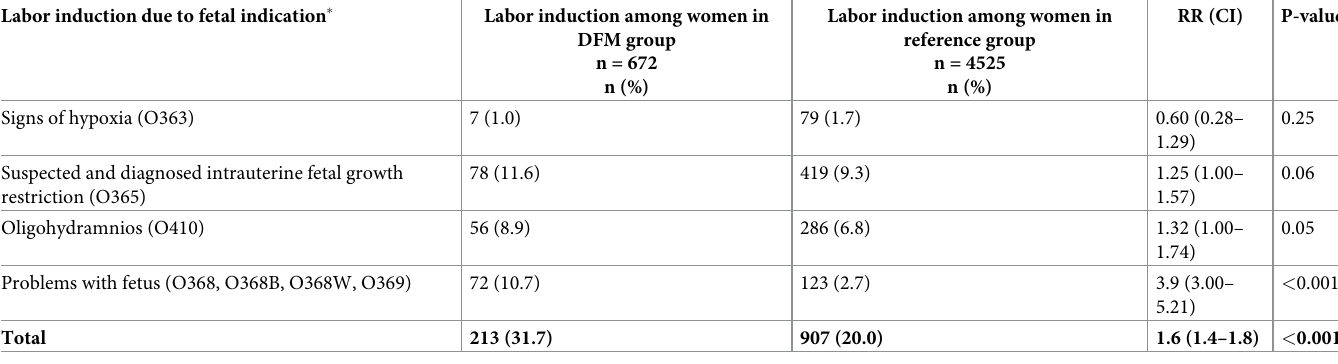
Table 4. Labor induction due to fetal indication among women in the DFM group and women in the reference group.